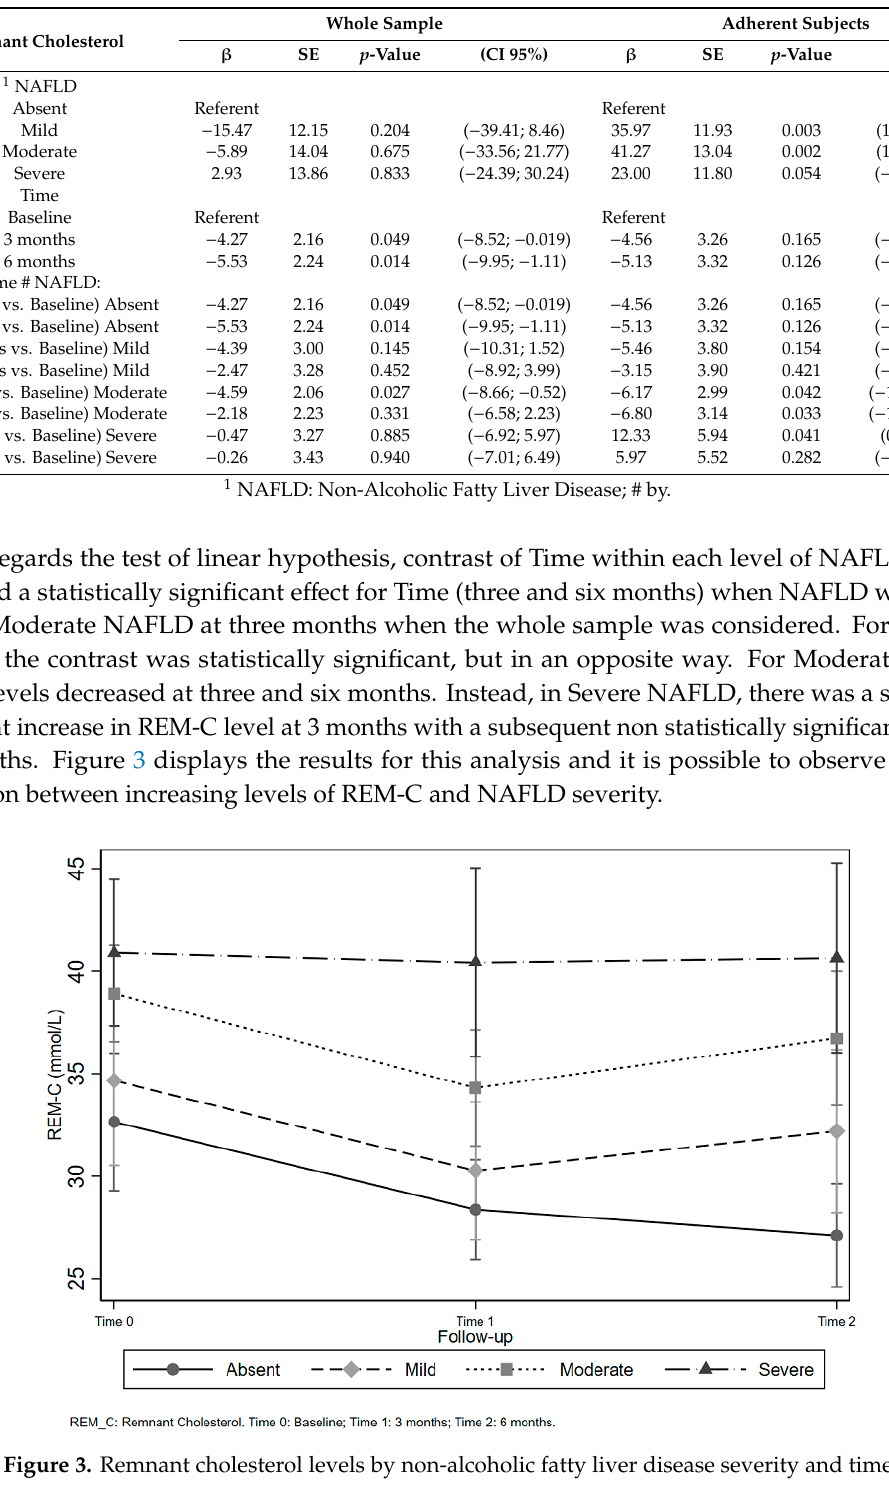
Table 4. Repeated measures analysis of variance. Principal e ff ects of NAFLD and time and contrast of time within each level of NAFLD in the whole sample and adherent subjects.